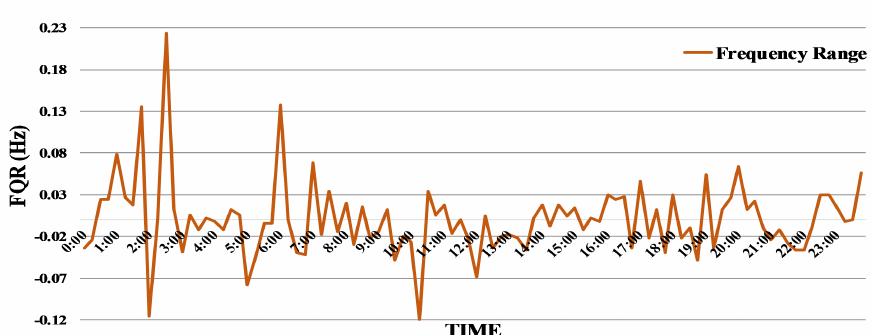
Figure 10. Frequency Range on the 23 August 2019.